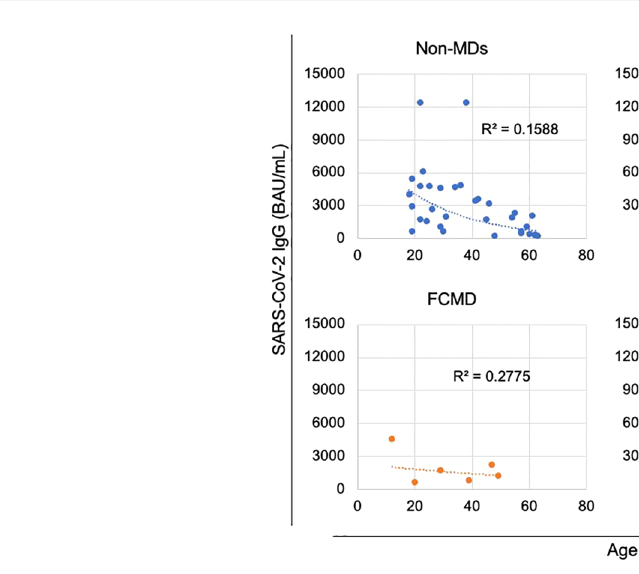
FIGURE 4 Correlations between anti-SARS-CoV-2 IgG antibody levels and the age of patients during the fi rst month after the second vaccination. Anti-SARS-CoV- 2 IgG antibody levels tended to decrease with age in the non-muscular disorder (MD) subgroup (n = 33) and in the DMD subgroup, which included patients with DMD (n = 21) or DMD-carrier (n = 1), unlike that observed in the Fukuyama congenital muscular dystrophy (FCMD) subgroup (n = 6) and the Myotonic dystrophy type 1 (DM1) subgroup (n = 9).